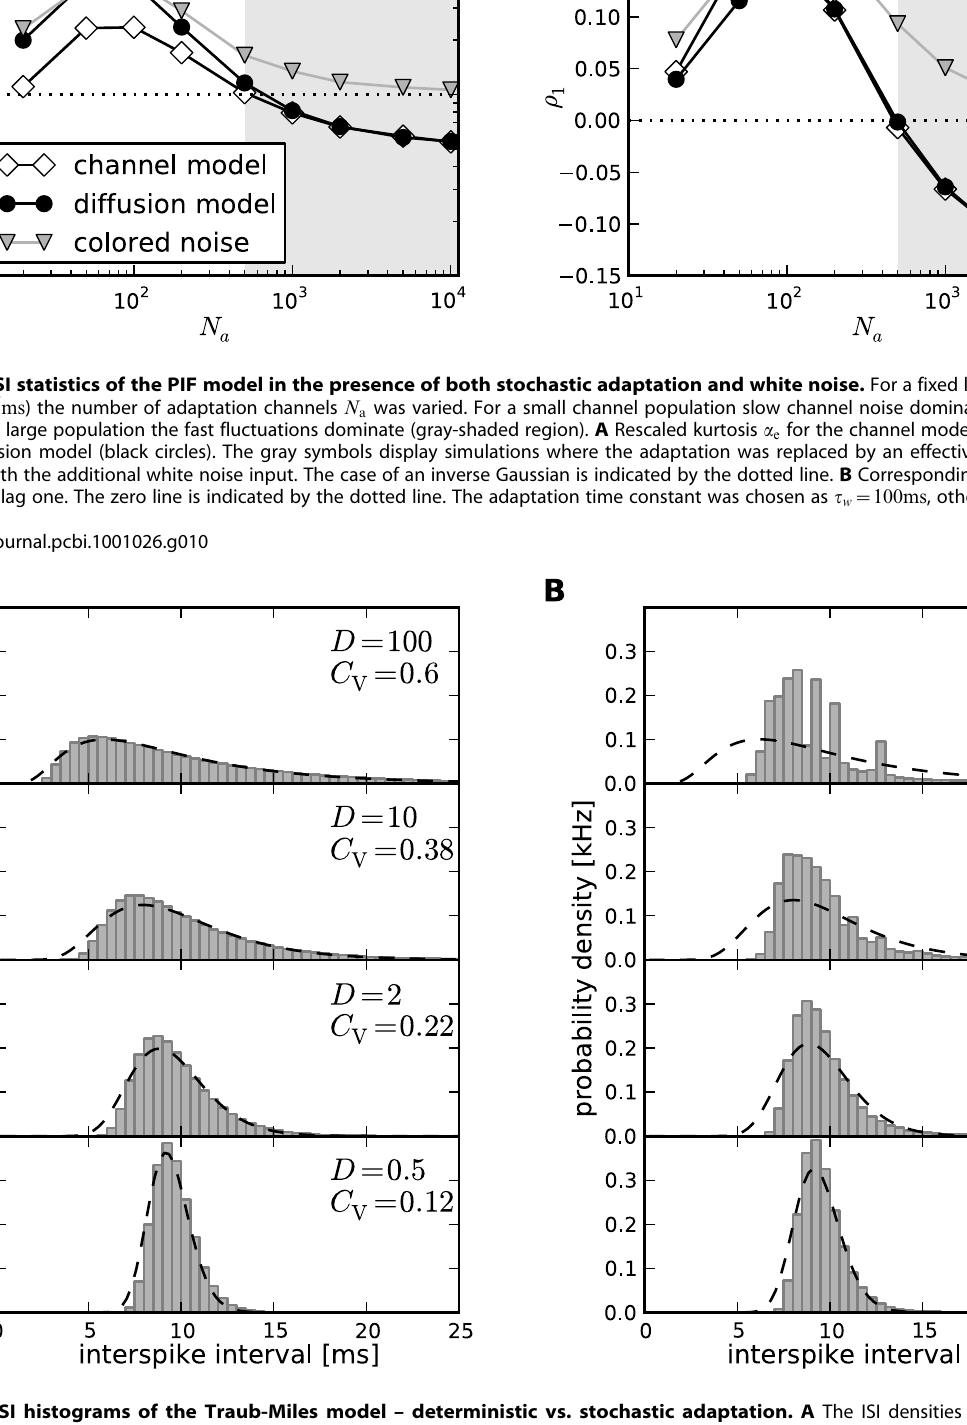
PLoS Computational Biology |